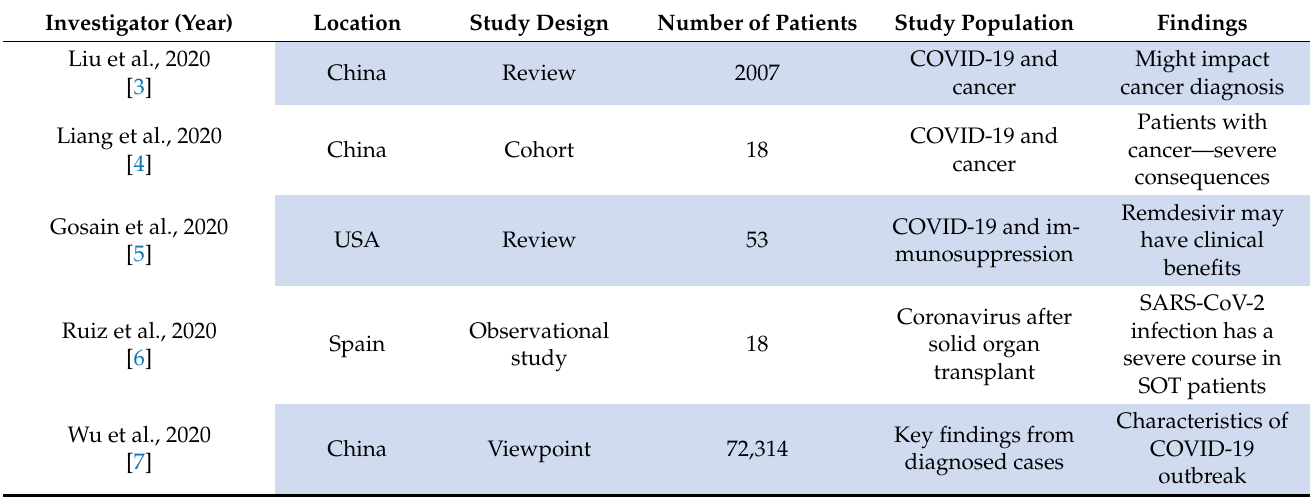
Table 1. Summary of the selected studies for the mini